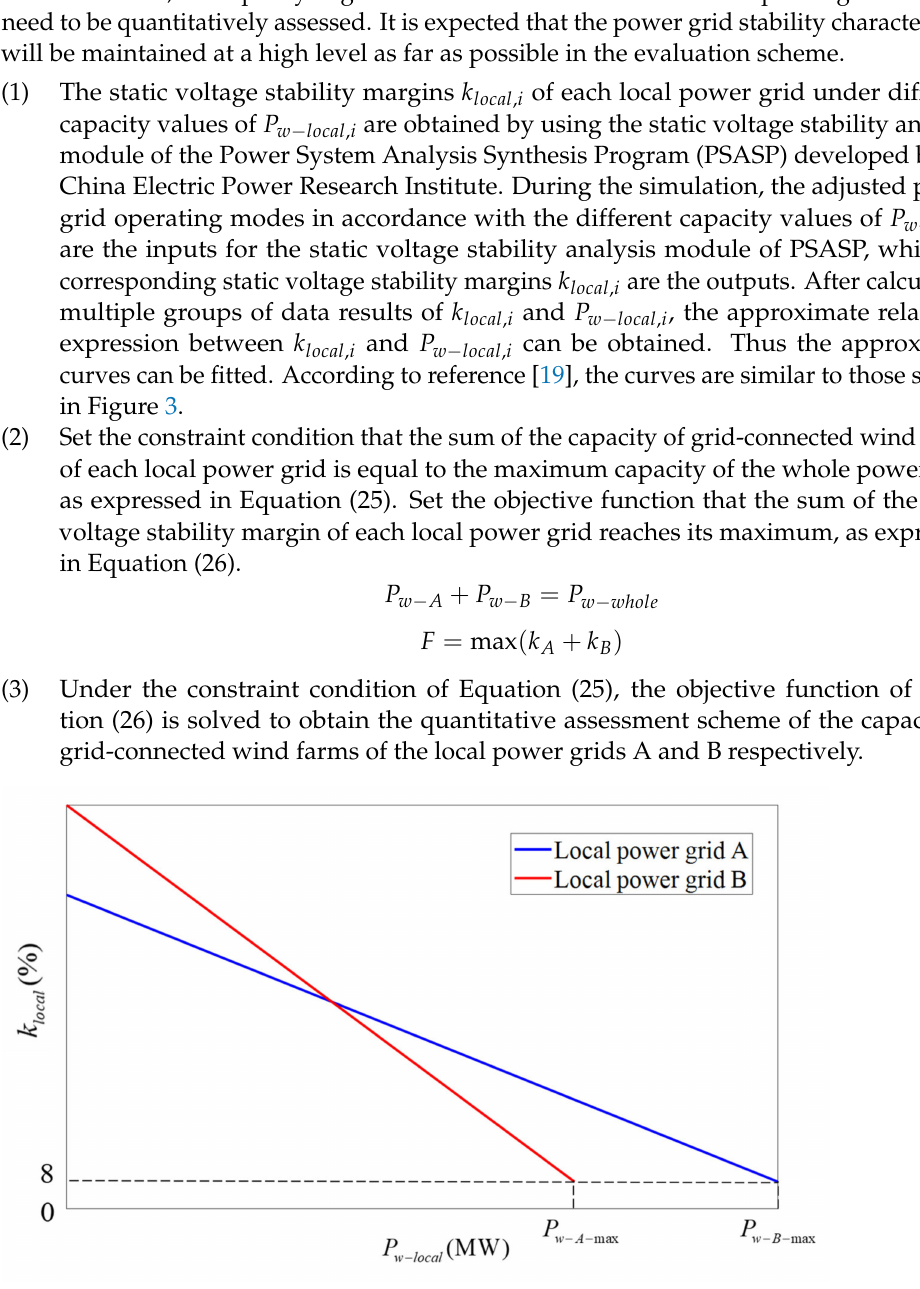
Figure 3. Approximate curves showing the relationship between k local and P w − local